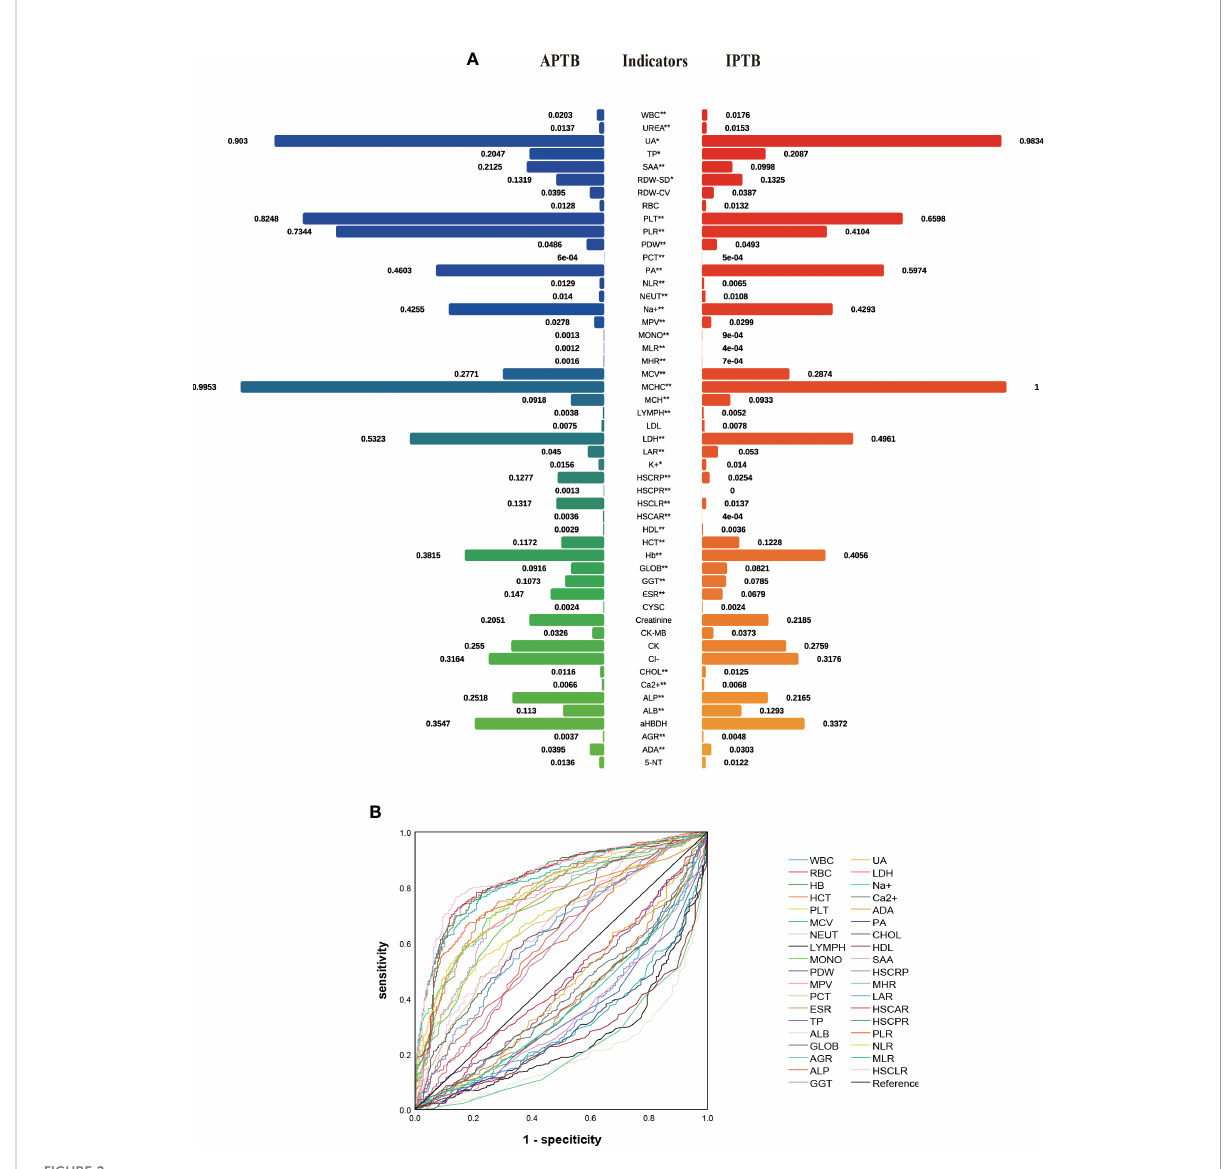
FIGURE 2 The performance of parameters in the training cohort. (A) The comparison between APTB and IPTB in the training cohort. The values represented the median after normalization to range between 0 and 1. *P < 0.05 and **P < 0.001; (B) The ROC analysis for signi fi cant parameters in univariate logistic regression analyses. Curves in the upper indicated that the levels of these indicators are higher in APTB than in IPTB. Curves in the bottom indicated that the levels of these indicators are lower in APTB than in